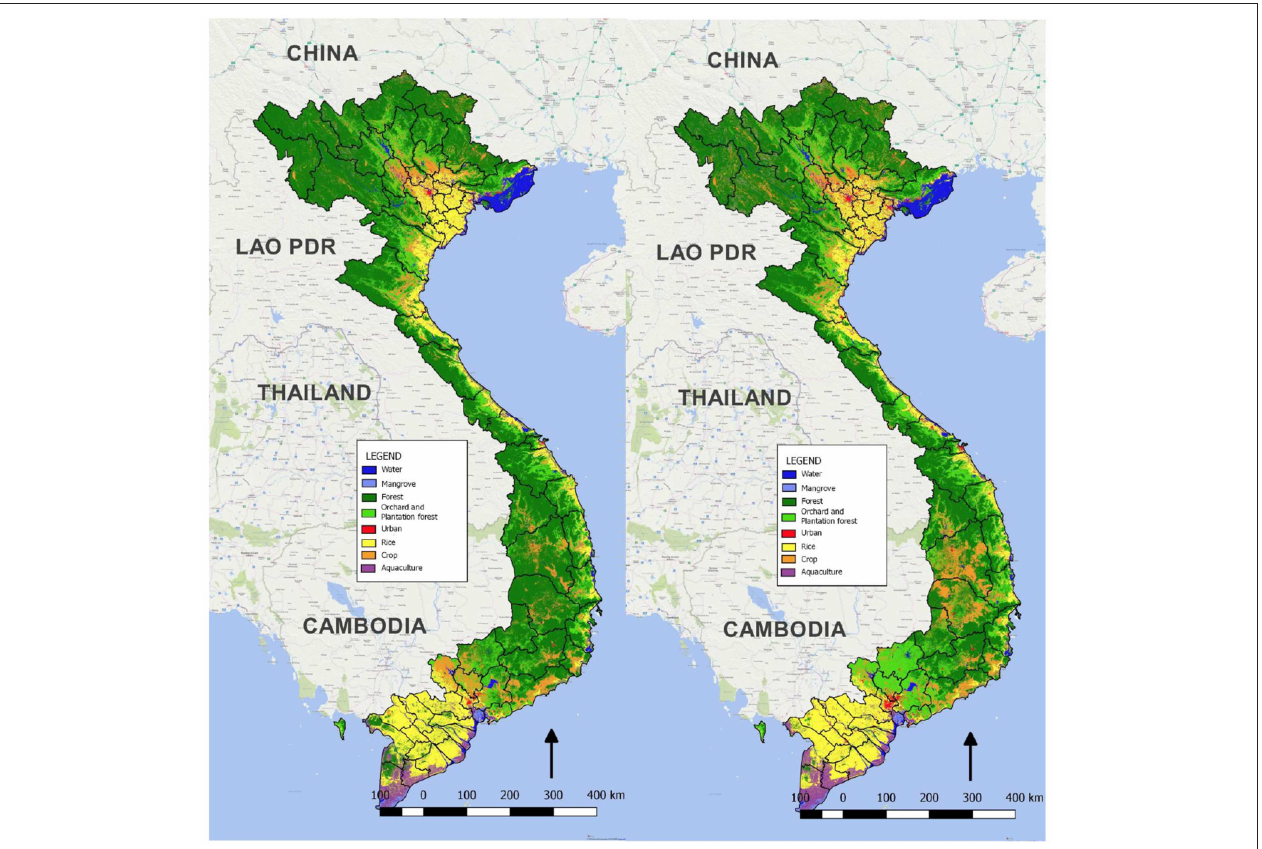
FIGURE 2 | Vietnam land cover map for the years 1988 (Left) and 2017 (Right) . Land cover maps of all years can be found online on the SERVIR-Mekong data portal, accessible at